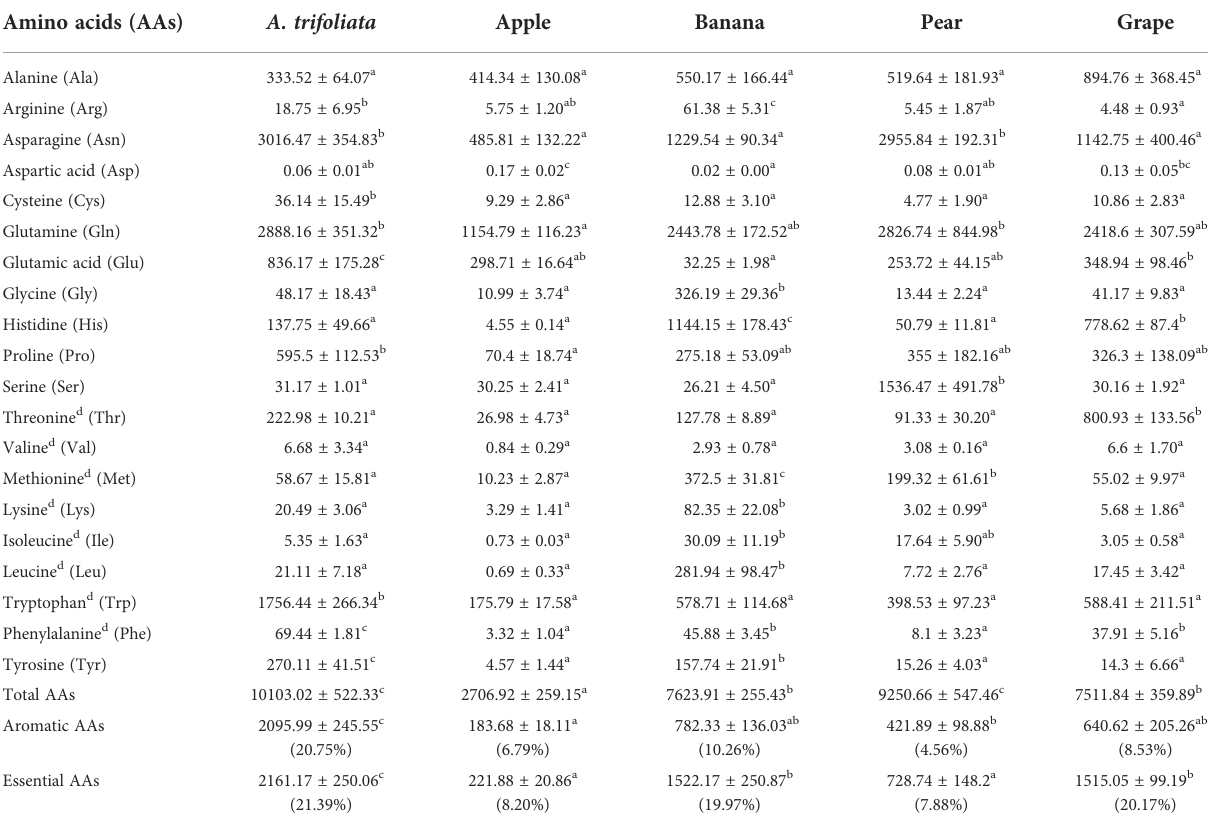
TABLE 1 Contents of free amino acids in the fl esh of A. Trifoliate. Amino acids